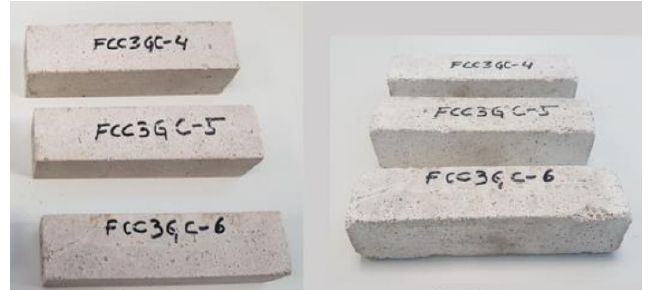
Figure 5. Photograph of the H-FCC/C mortar after 0 ( left ) and 30 ( right ) freeze–thaw cycles. Figure 6 represents the percentage of loss in compressive and flexural strengths. As